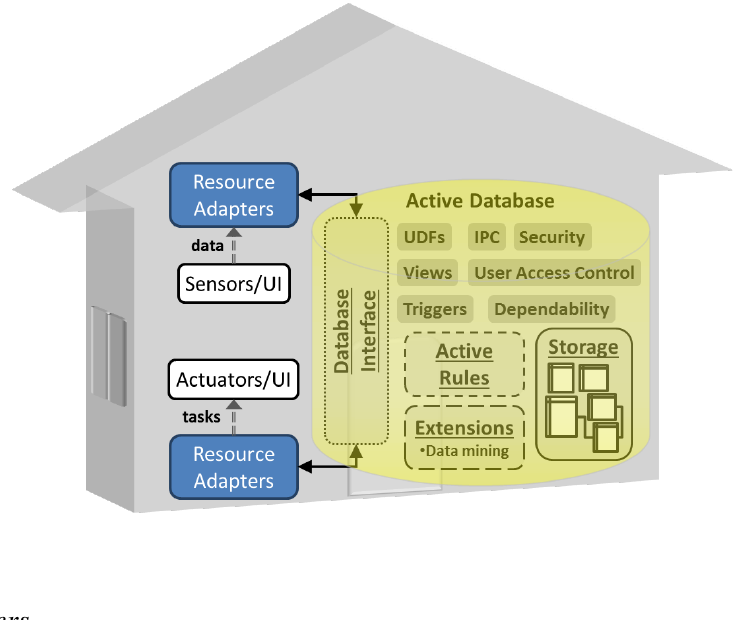
Figure 3. The proposed system architecture, including resource adapters and the active database. Notation: UI, user interface; UDFs, user-defined functions; IPC, inter-process